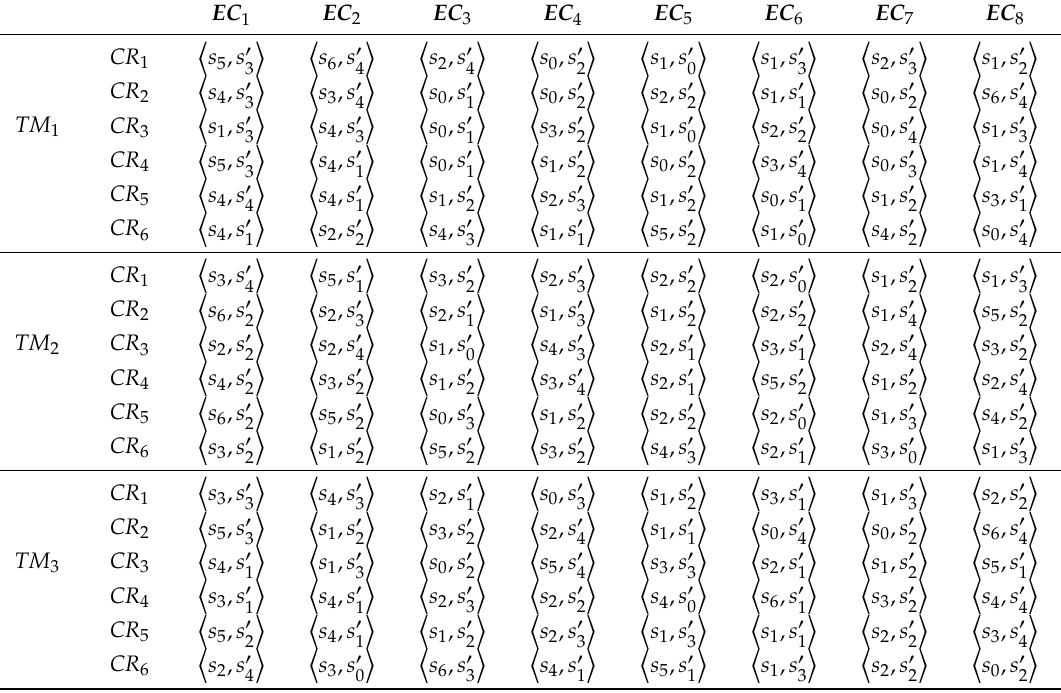
Table 3. The relationship evaluation information between CRs and ECs.